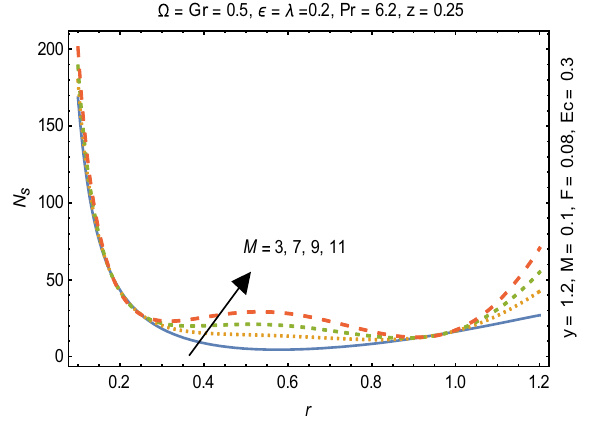
Figure 8. Variation in N s for M.